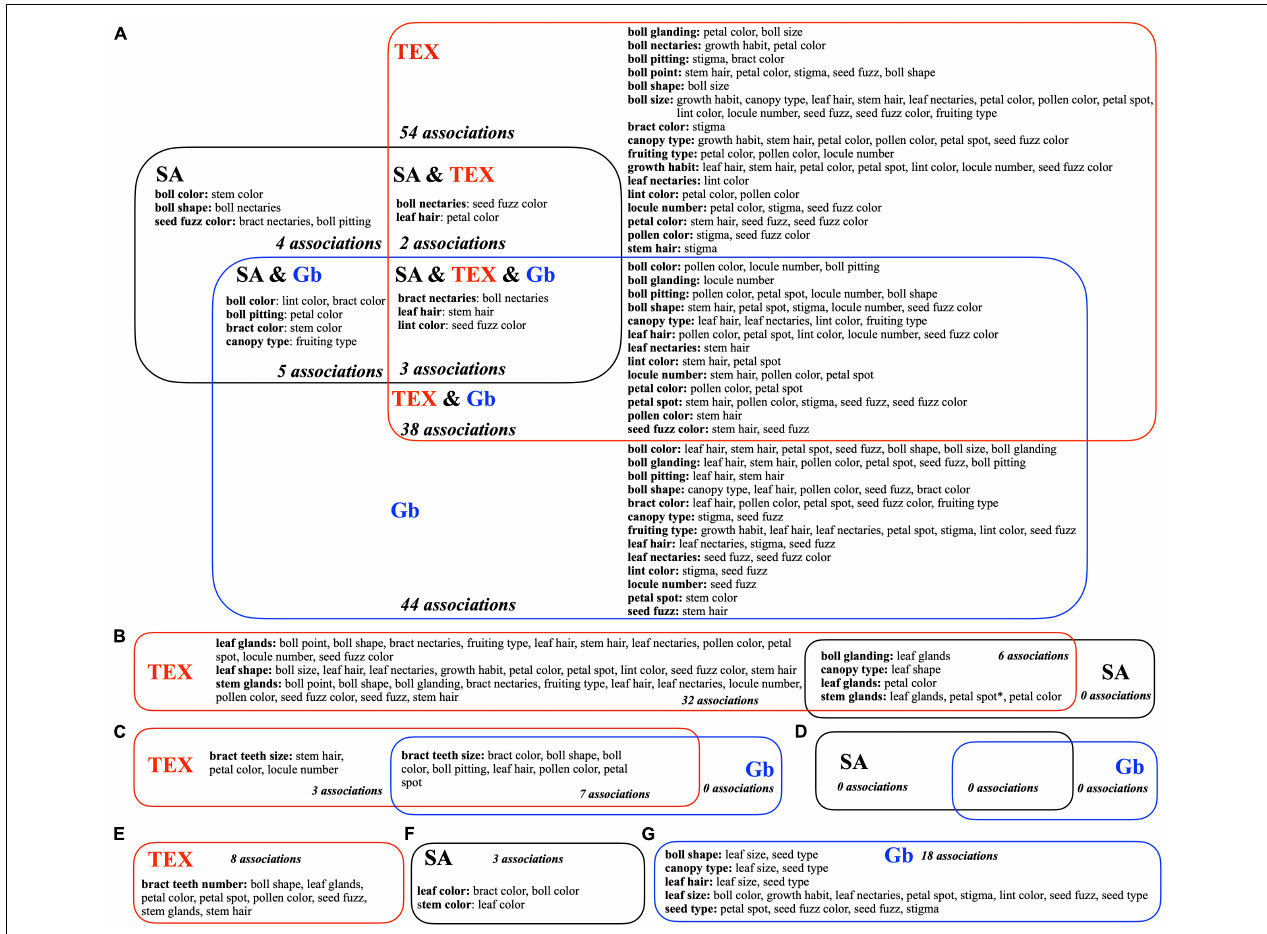
FIGURE 6 | Venn diagrams showing high confidence bivariate descriptor associations within and among three groups of Gossypium accessions, SA, TEX, and Gb. Bivariate significance is based on the FDR adjusted P -values. Each sector is labeled with the relevant group name(s) and the number of associations it contains. Descriptors within a sector that had high confidence associations ( P < 0.01) are listed in bold and alphabetical order, with the associated descriptors following in plain text. For example, in the SA and Gb sector (A) , the first line indicates two high confidence bivariate associations: boll color with (1) lint color and boll color with (2) bract color. Descriptors listed in plain text may occur in more than a single bold category, but each bivariate descriptor-to-descriptor combination should occur only once in the whole diagram. If an association between two descriptors does not appear, the p -value was > 0.01 for that comparison. (A) Significant categorical descriptors evaluated between the three groups. (B) TEX vs. SA. (C) TEX vs. Gb. (D) SA vs. Gb. (E) Only TEX. (F) Only SA. (G) Only Gb. ∗ In (B) , the TEX and SA stem glands:petal spot association is the only case where the states of the descriptor states was independently modified for each group (modification shown